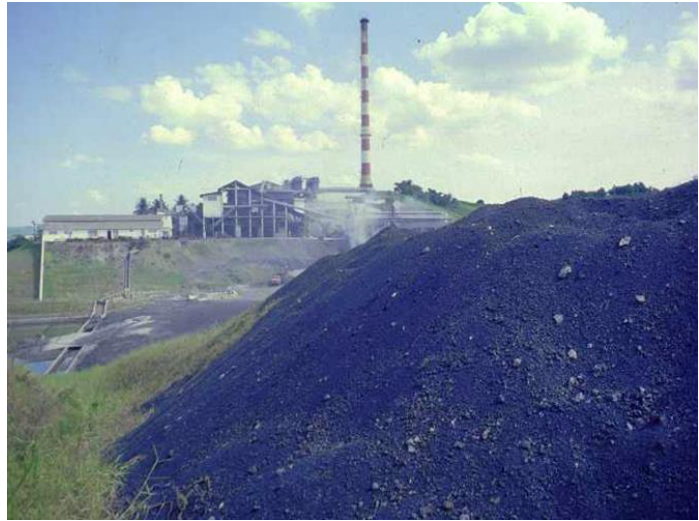
Figure 1. The big dross pile on the smelter ground, 1999.